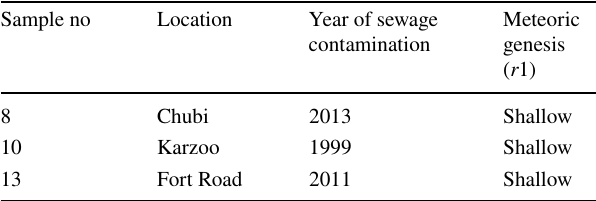
Table 4 Contaminated groundwater sources and their depths Sample no Location Year of sewage